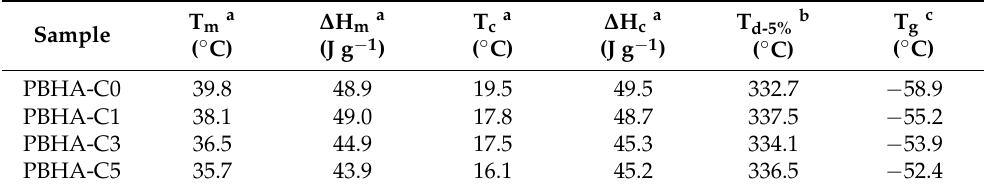
Table 2. Thermal properties of PBHA-Cn copolymers.